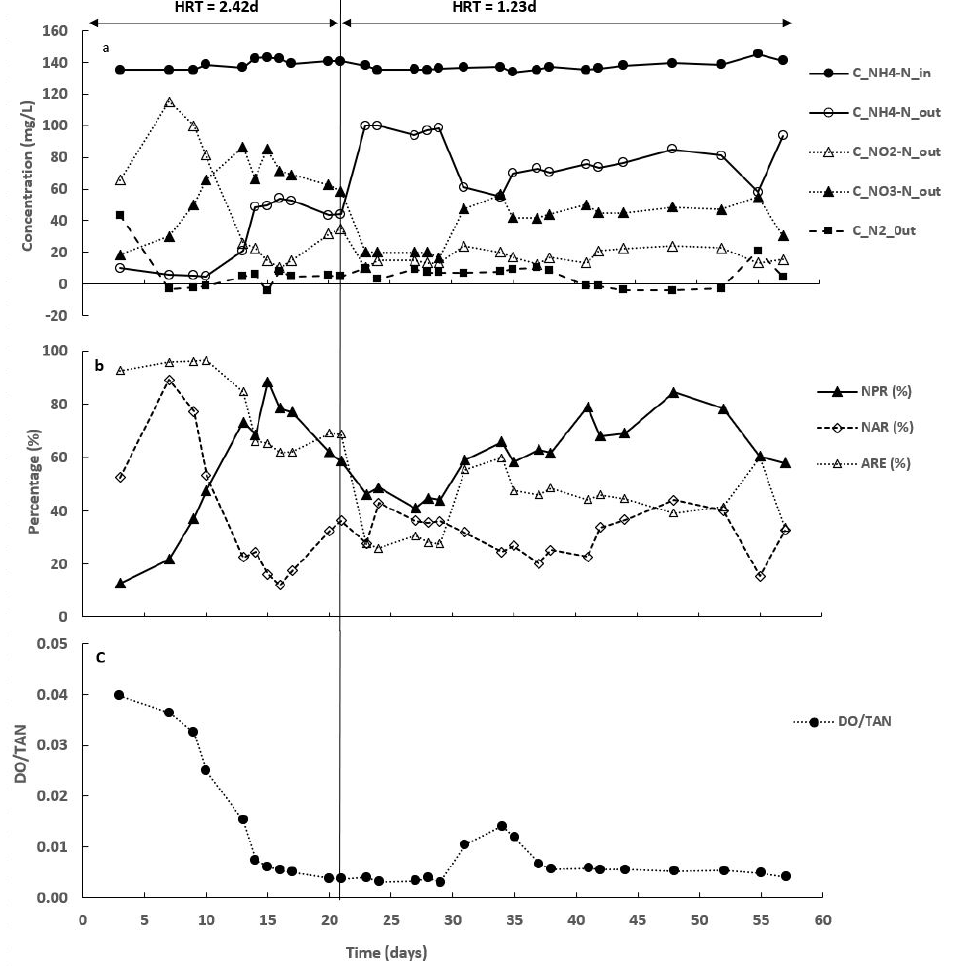
Figure 4. Nitrogen compounds transformation under continuous aeration: ( a ) inlet and outlet nitro- gen compounds variations; ( b ) Production and removal percentage of nitrogen compounds; ( c ) DO/TAN ratio as an operating parameter.